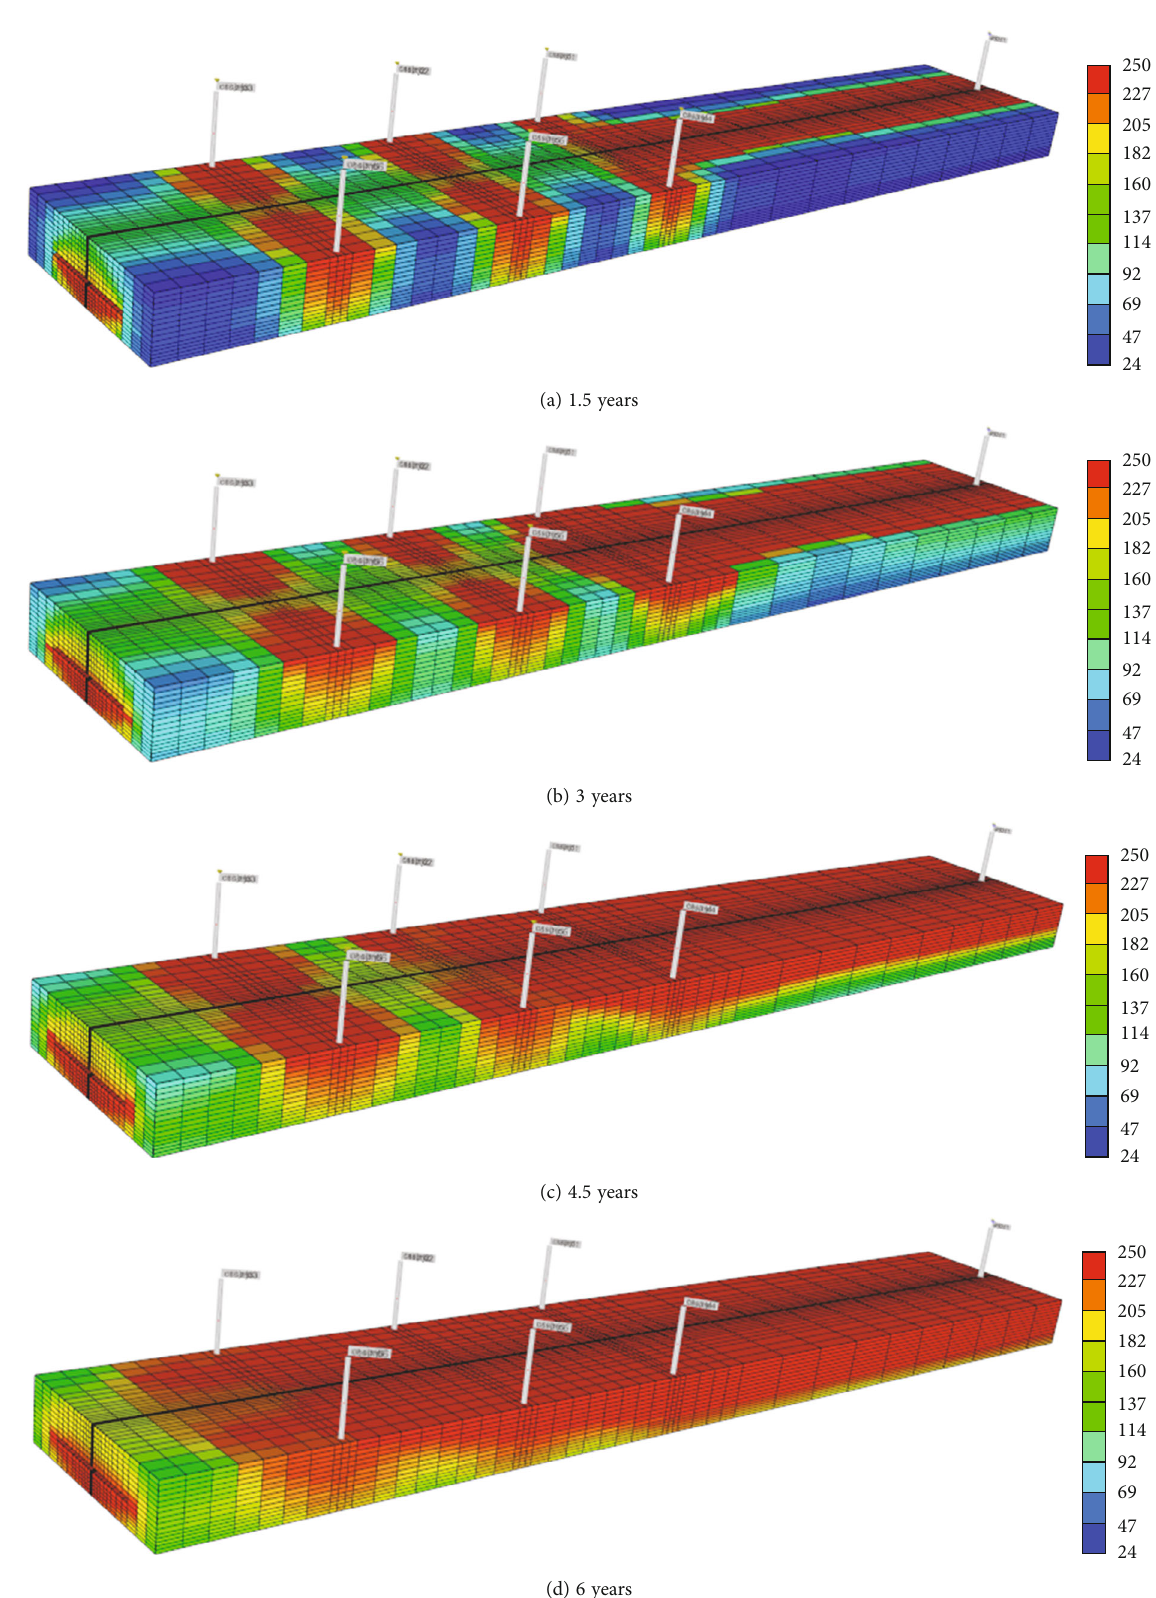
Figure 18: Temperature fi elds at di ff erent